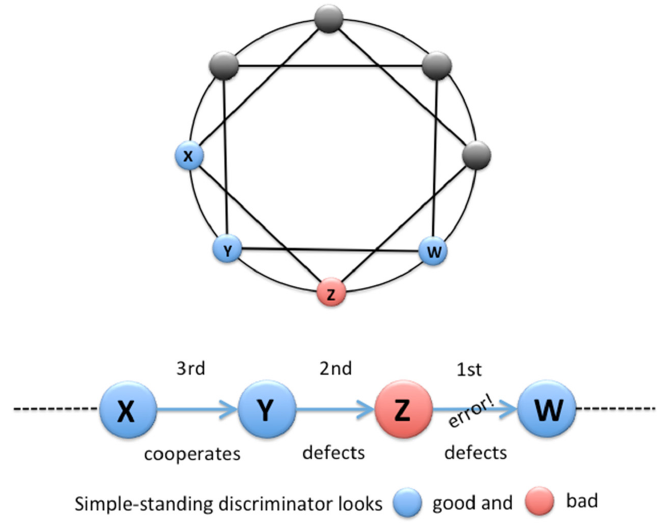
Figure 1. Actions and assessments in the giving games in a regular network with a population size